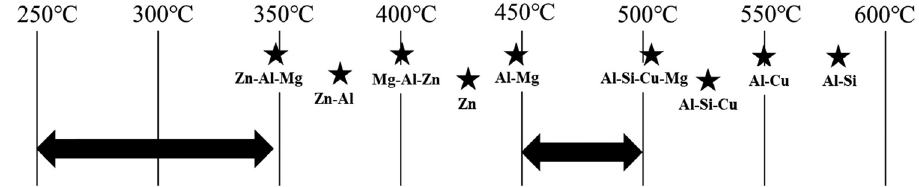
Figure 1: Representative eutectic alloys for PCMs ( plots represent eutectic temperatures of each alloy )